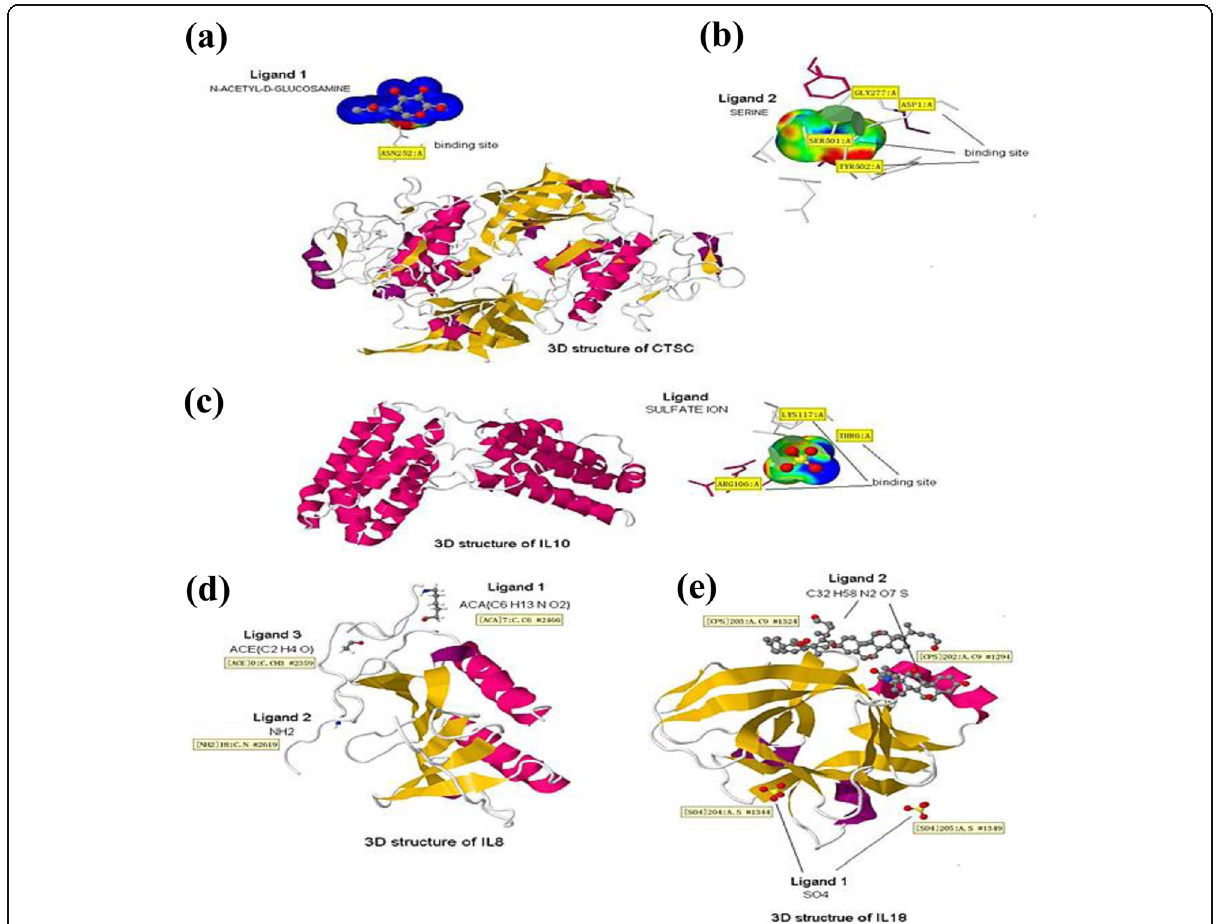
Fig. 5 3D structure of four selected proteins. Ligand 1 and 2 were ligand molecular which can dock and bind to the active sites of proteins ( a , b ). Words in the yellow boxes were the information about the active binding sites. In the 3D structures, red ones mean α -helix, the orange ones mean β -fold. a – e Represents CTSC, IL10, IL8, and